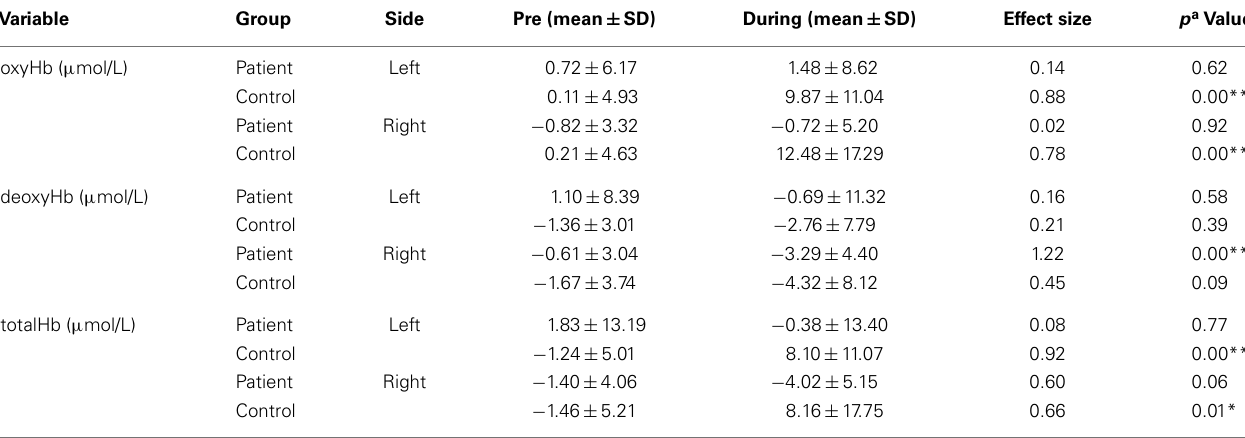
Table 2 | Means and standard deviations of frontal hemodynamic responses before and during KB practice in patients and controls.